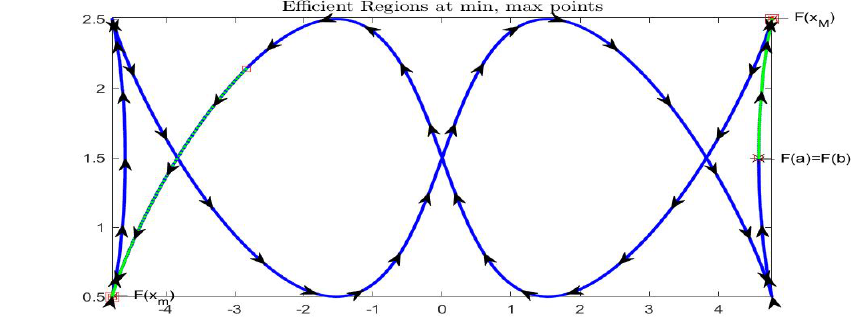
Figure 22. Periodic Example 2 (Siamese fishes): midpoint representation of function F ( x ) ; marked points are F ( x m ) and F ( x M ) and the efficient E min ( F ; x m ) and E max ( F , x M ) points are marked in green